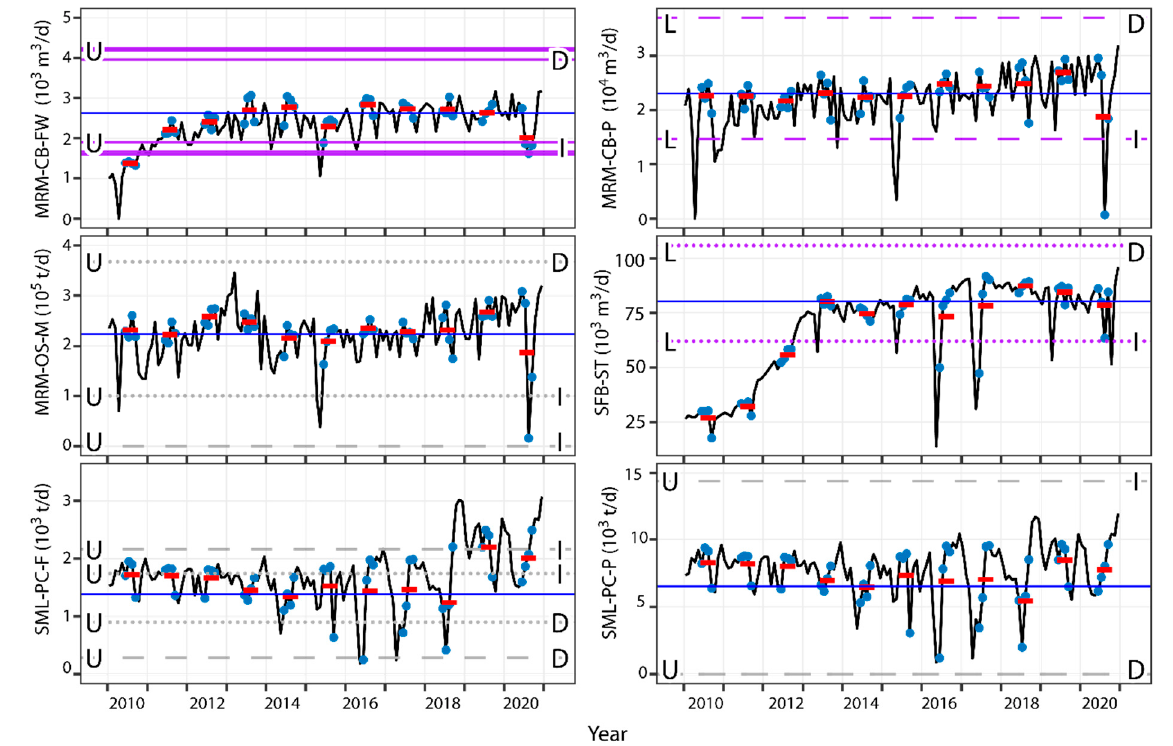
Figure 5. Effect size plots from mean (horizontal blue lines) with greater or lesser industrial activities; purple lines = females; dark gray = males; solid lines = gonad weight; dashed lines = liver weight; dotted lines = body weight; L = Lower site; U = Upper site; D = decrease in fish measurement; I = increase in fish measurement; black lines = monthly industrial values from 2010–2020; blue dotes = June, July, August, September; Red lines = mean summer values for industrial endpoints.